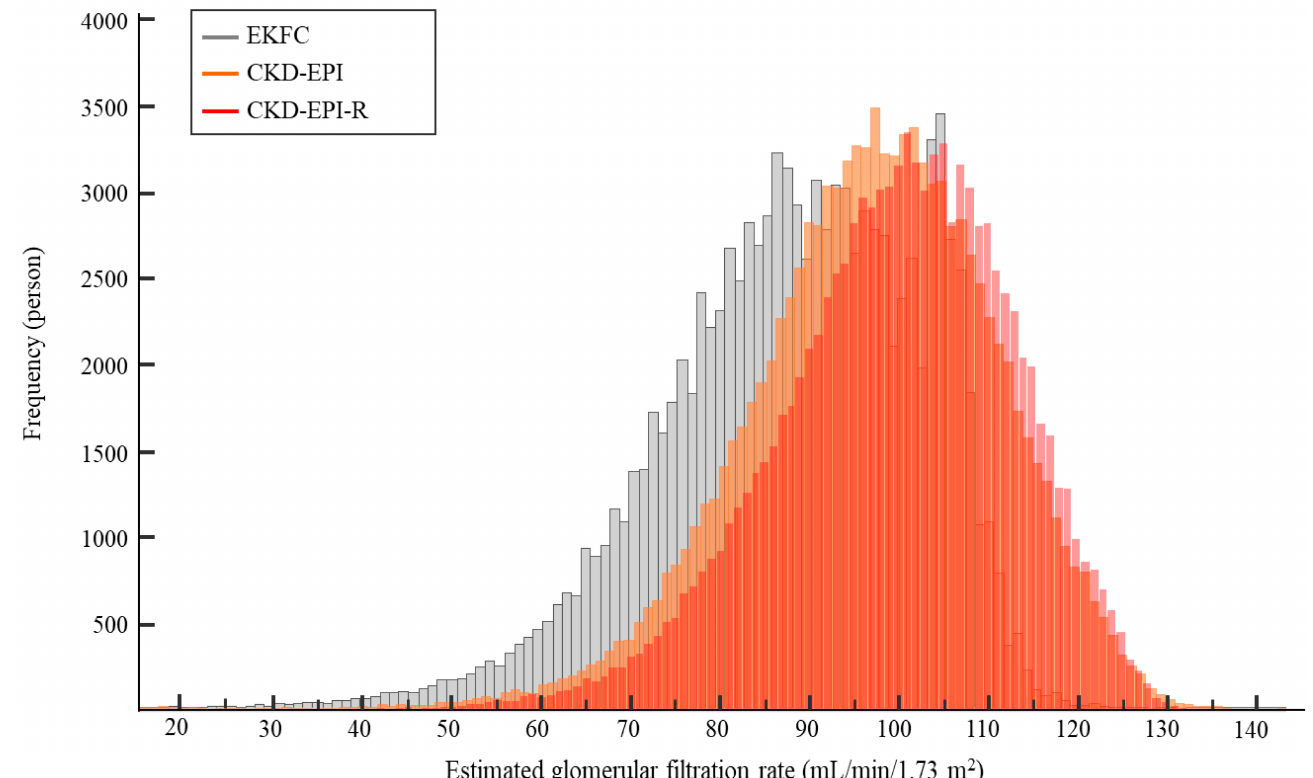
Figure 1. Distribution of eGFR using serum creatinine-based CKD-EPI, EKFC, and CKD-EPI-R equations. Abbreviations: see Table 1.